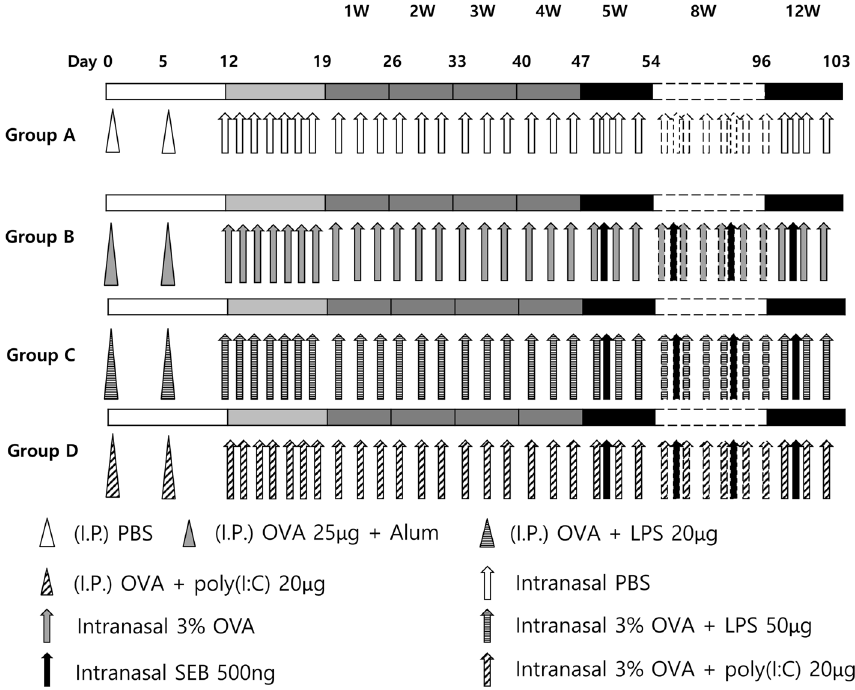
Figure 5. Experimental protocol. This figure was drawn using Microsoft’s PowerPoint 2016 (https ://www.micro